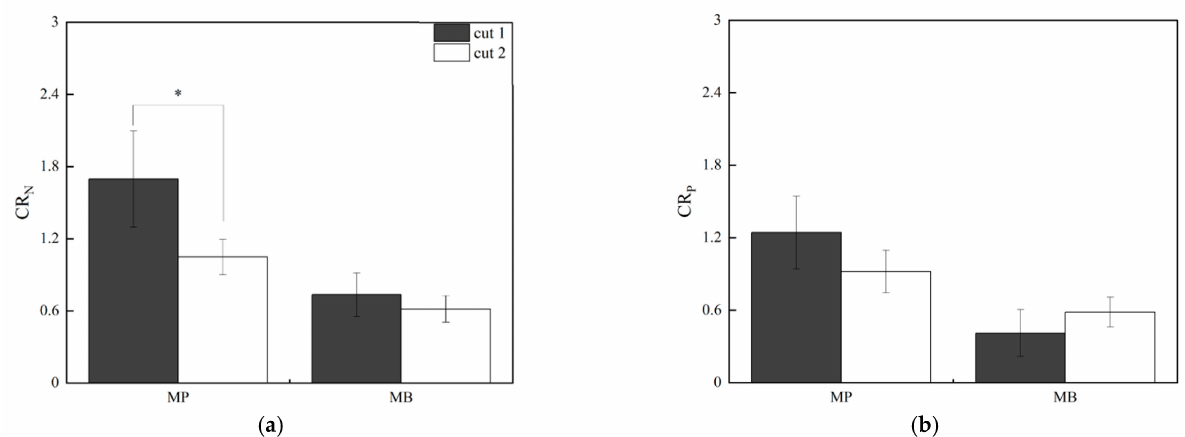
Figure 3. Cut-level competition ratios for ( a ) N (CR N ) and ( b ) P (CR P ) of lucerne under different species combinations. Values are the means ± SD (n = 9). The asterisk (*) indicates a significant difference between the two cuts of the MP mixtures at p < 0.05.